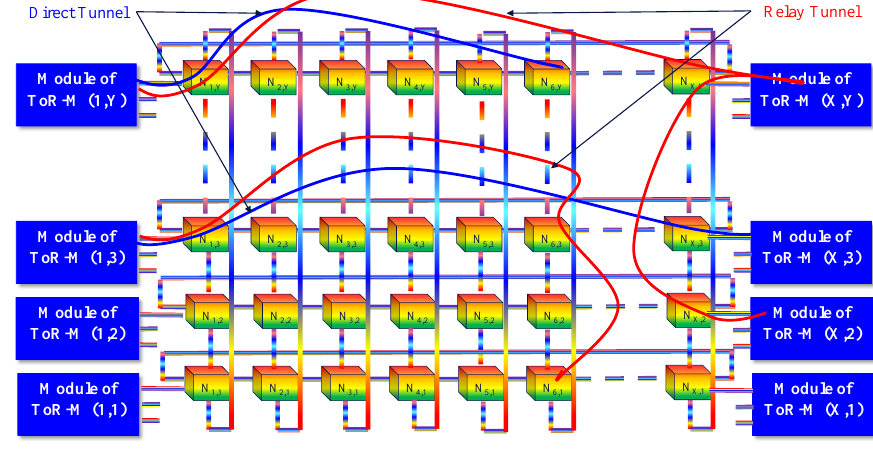
Figure 9. Tunnel creation of first plane.